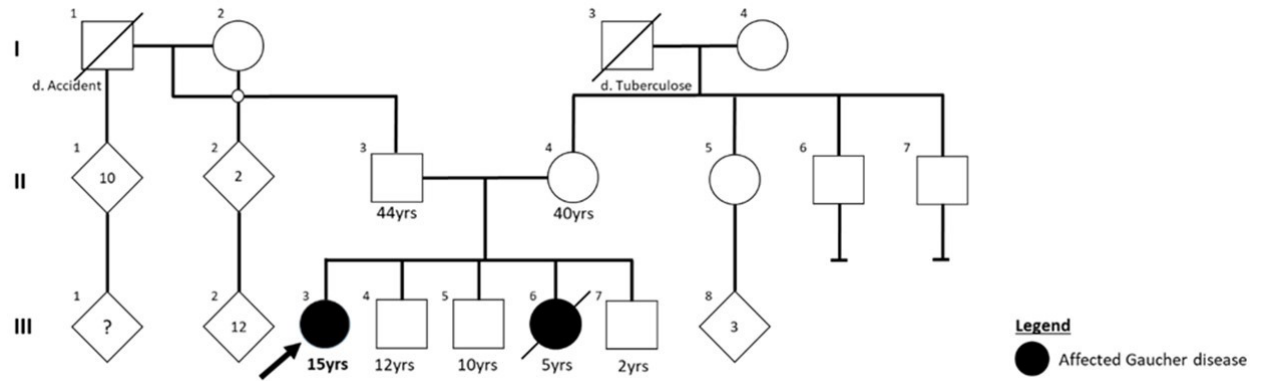
Figure 1. Family history. Members III3 and III6 were identified as having GD. III6 was diagnosed by histological examination in